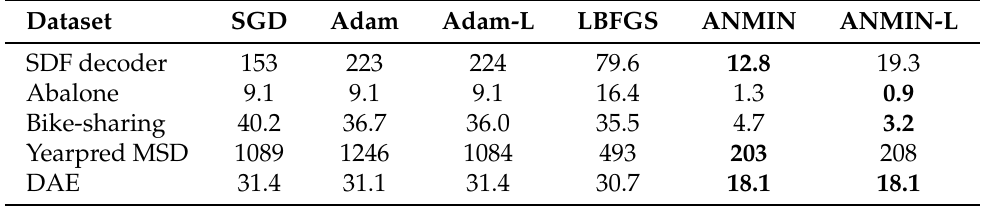
Figure 6. MSE and average R 2 vs. time (seconds) of 100 runs of training the NN with ReLU activation using the LBFGS and ANMIN optimizers. Additionally plotted are the mean test MSEs and R 2 with standard deviation. Table 4. Computation times (seconds) for the experiments from Table 3. Smallest times are shown in